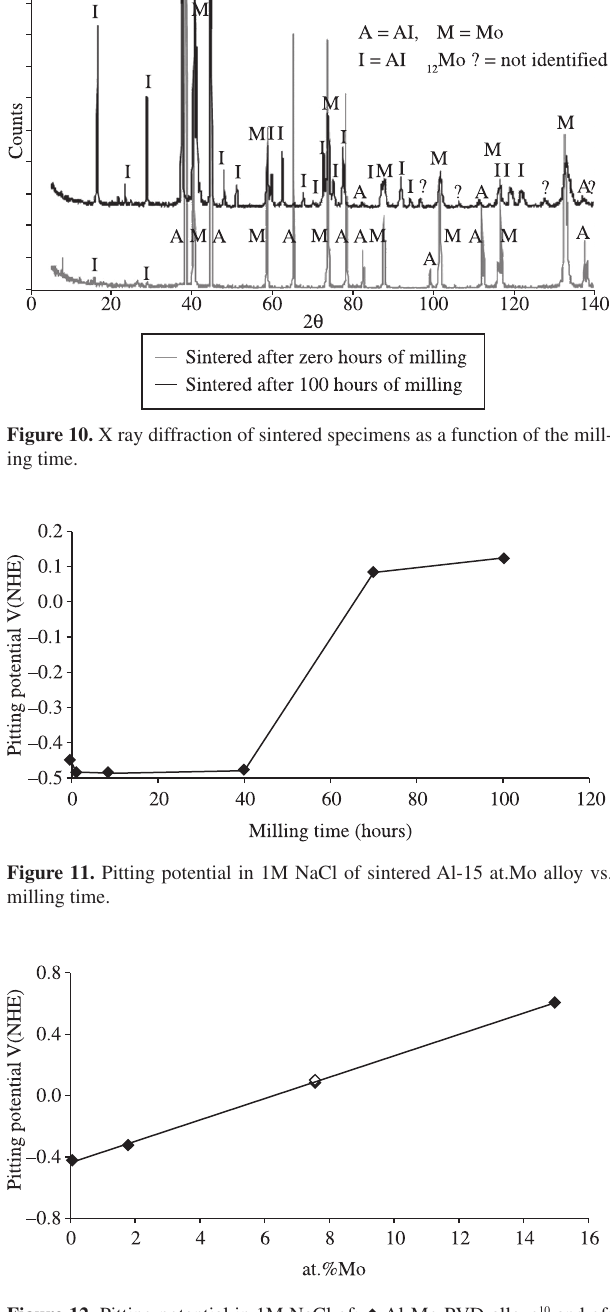
Figure 12. Pitting potential in 1M NaCl of:  Al-Mo PVD-alloys 10 and of:  Al Mo phase (7.7 12